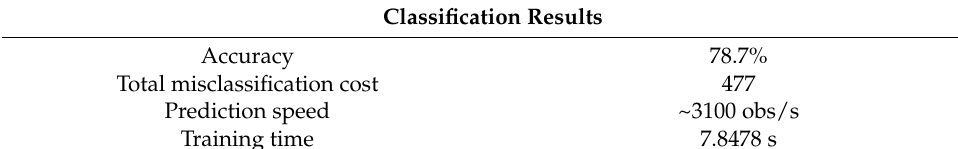
Table 16. Classification results for thick samples based on transmission mode.